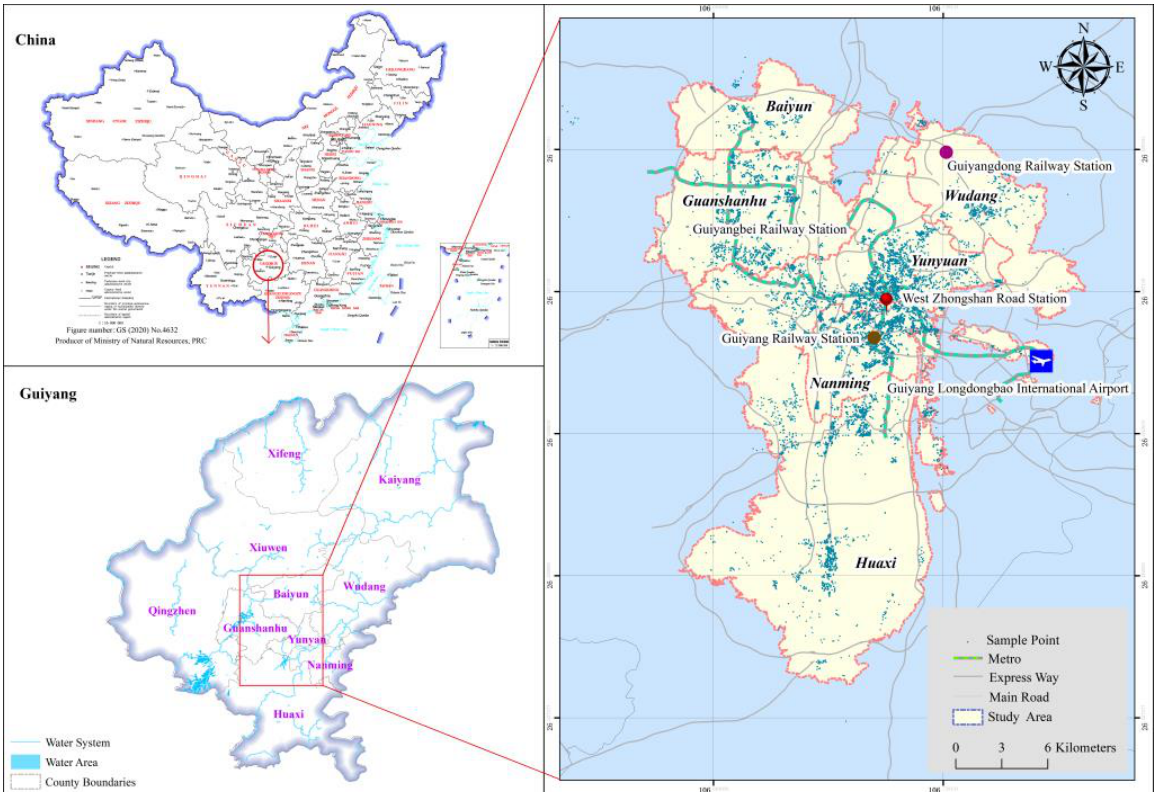
Figure 1. Map of the urban area of Guiyang and the respondents’ household locations.